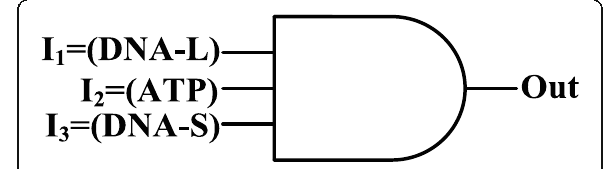
Fig. 4 Three input single output (3:1) AND logic